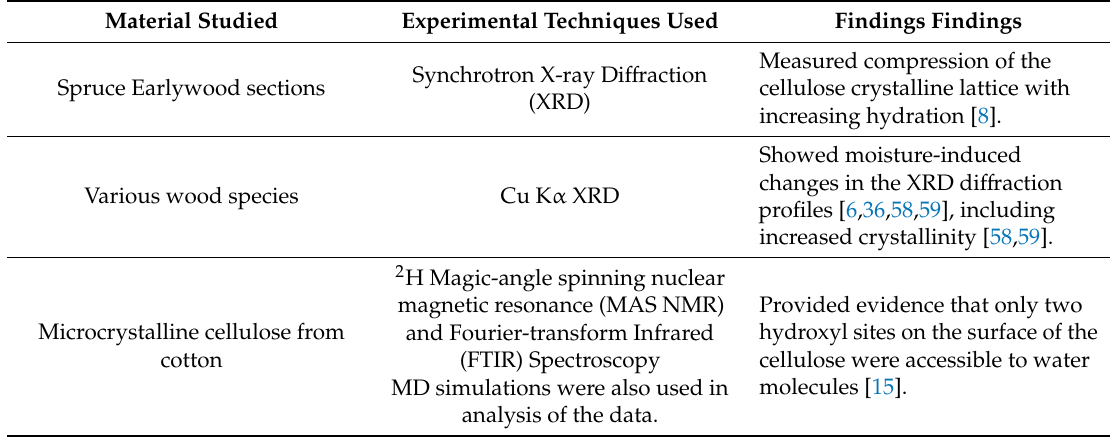
Table 1. Summary of studies on the moisture-dependent behavior of the wood